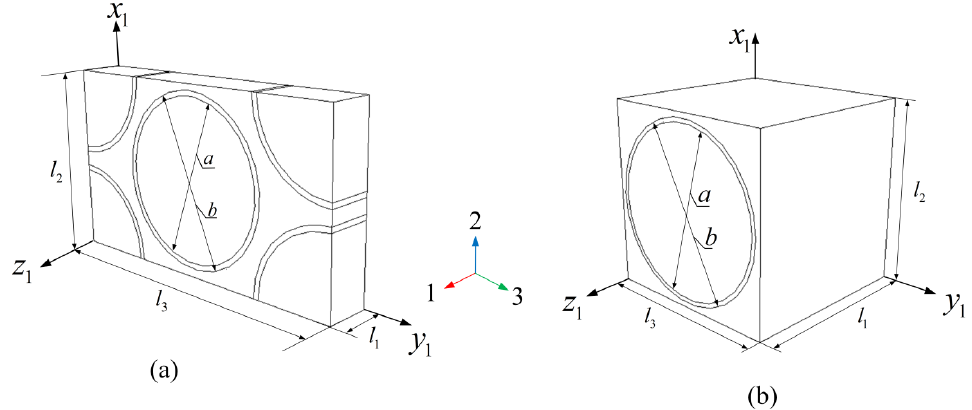
Figure 4. Microscale RVE of the yarn consisting of fibers and the matrix: ( a ) H-RVE; ( b ) S-RVE.